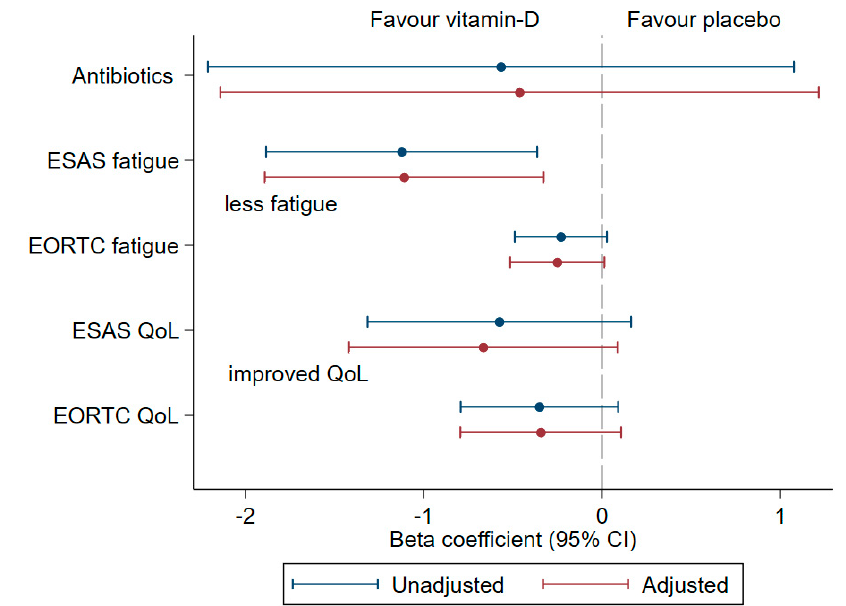
Figure 3. Secondary outcomes: forest plot with beta coefficient and 95% CI over the antibiotic consumption, fatigue and QoL assessed with ESAS and EORTC QLQ-C15-PAL in the ‘Palliative-D’ study. The analysis is based on the Per Protocol (PP) analysis of the 150 patients completing the 12-week study period (vitamin D 4000 IE/day n = 67 and placebo n = 83). Adjustments were made for the baseline in all analyses and for age, sex, oncological treatment, baseline 25-hydroxyitamin D and colectomy in the “adjusted model.” The scale of EORTC QLQ-C15-PAL has been reversed so the negative value of beta is an improvement in QoL, in line with all the other outcomes where negative value shows improvement.